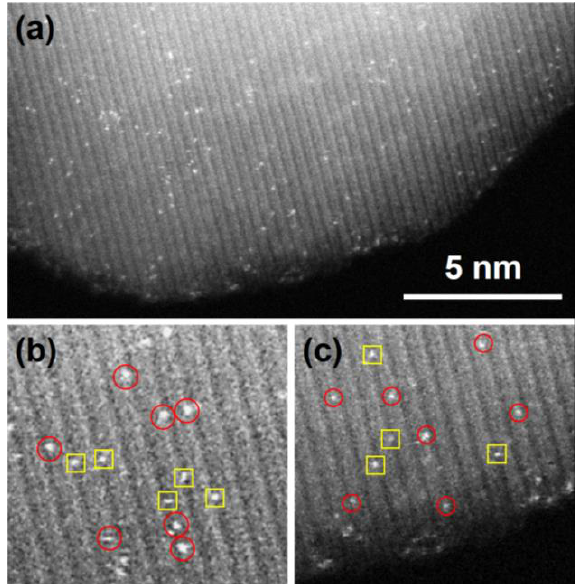
Figure 10. Pt 1 /Fe 2 O 3 supported single atom catalyst. ( b ) and ( c ) are the enlarged HAADF-STEM images of two parts in image ( a ) for Pt 1 /Fe 2 O 3 SAC. The red circles indicate the isolated Pt atoms occupied Fe-top positions, and the yellow squares indicate that the isolated Pt atoms possess O-top positions. Reproduced from [133], with permission from IOP Publishing, 2018.